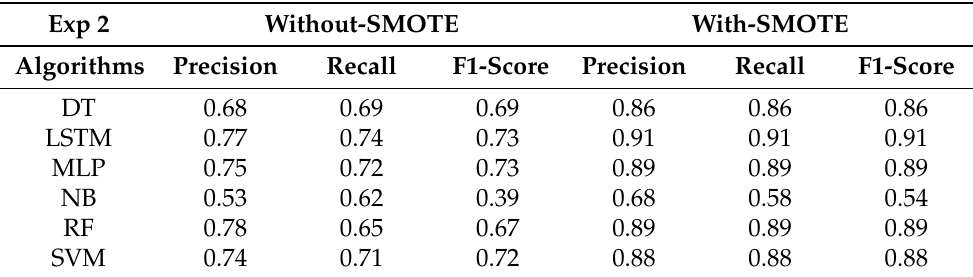
Table 4. Exp2 Scores (Precision, Recall,